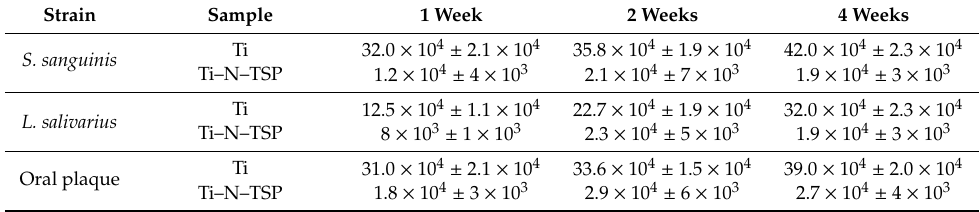
Table 4. Live bacteria of two bacteria strains ( Streptococcus sanguinis and Lactobacillus salivarius ) and complete oral plaque at 37 ◦ C for 1, 2 and 4 weeks (mean ± standard deviation (SD)).